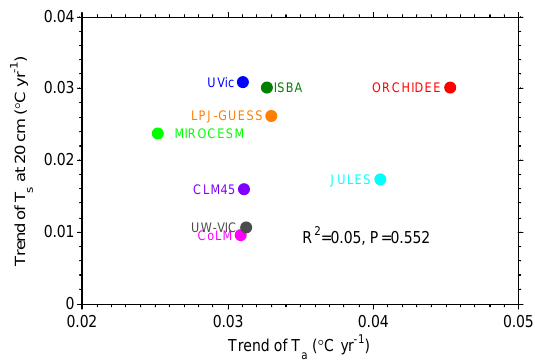
Figure 7. Simulated trends of annual T s at 20cm and T a in the climate-forcing data across the nine